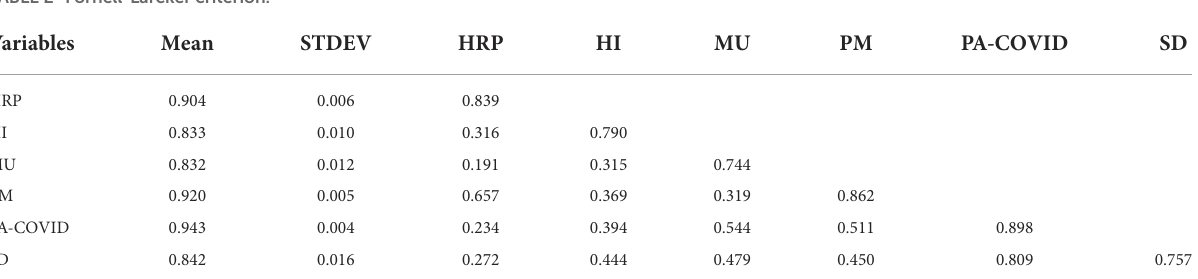
FIGURE3 Measurement model.